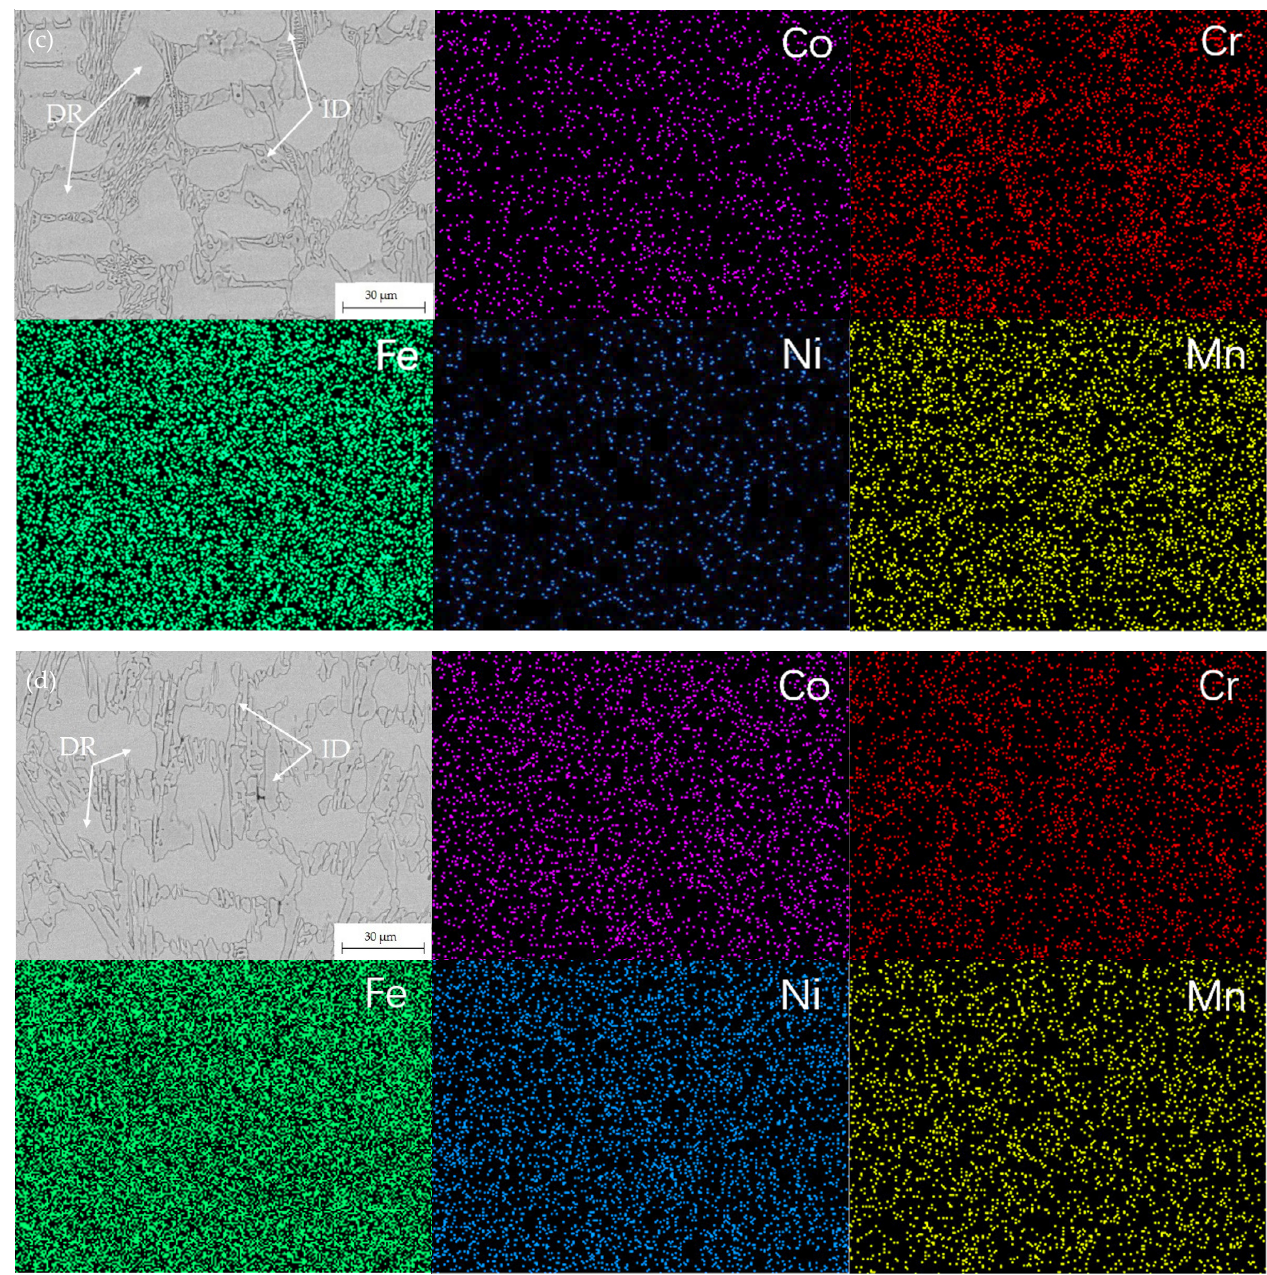
Figure 5. Cross-sectional distribution of elements in the CoCrFeNiMn HEA coatings at different plasma arc currents: ( a ) 50 A, ( b ) 55 A, ( c ) 60 A and ( d ) 65 A.